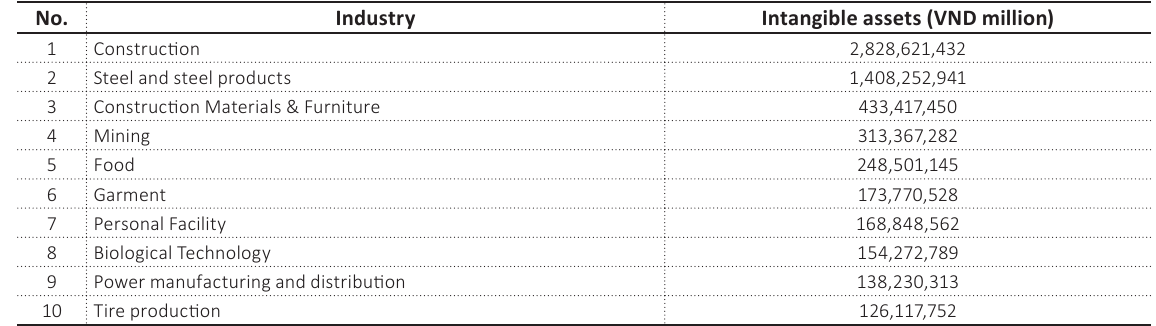
Table 3. Top 10 industries in Vietnam with highest intangible assets in 2014